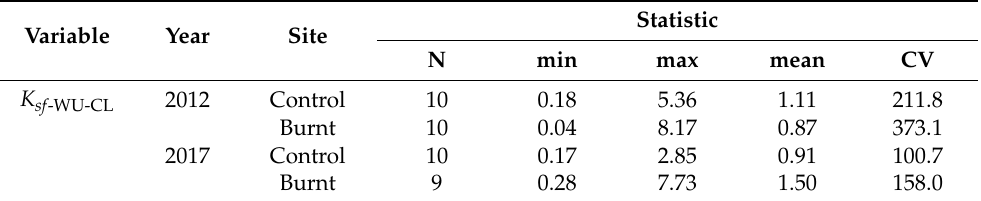
Table 1. Summary of the field-saturated hydraulic conductivity, K fs (mm · h − 1 ), values obtained by the WU1 method for each sampling campaign and site.